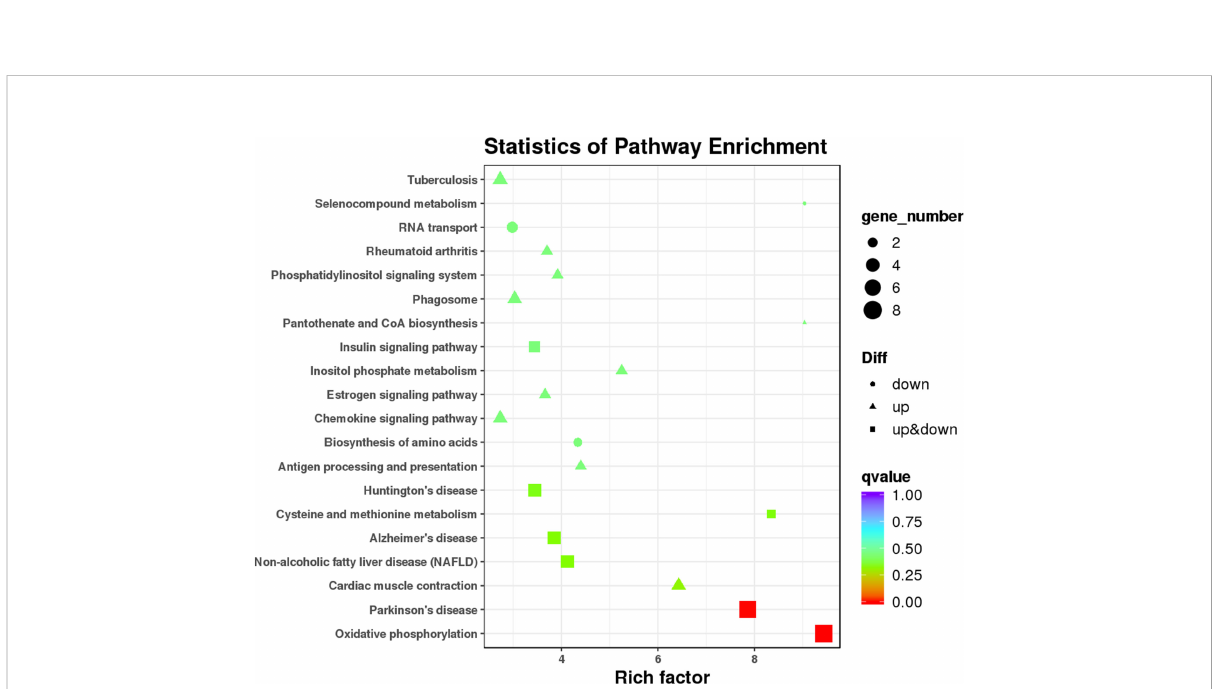
FIGURE 6 Kyoto Encyclopedia of Genes and Genomes (KEGG) pathway analysis of 112